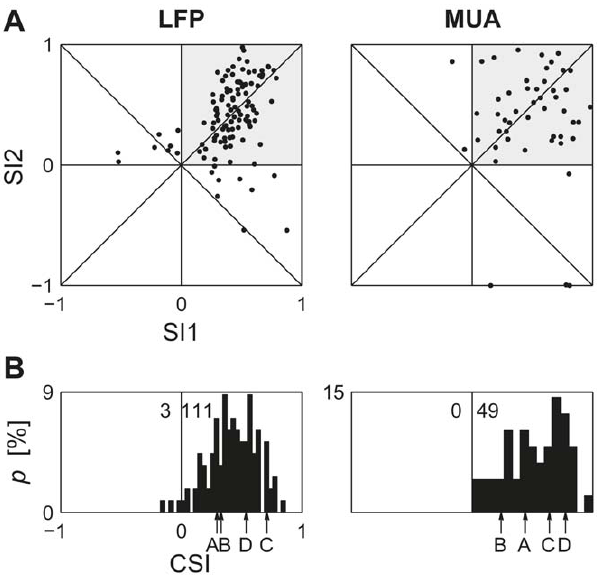
Figure 2. SSA indices for D f=44%. A. Scatter plots of SI2 vs. SI1 for all sets with D f=44%. B. Histograms of CSI. The numbers near the zero line indicate the number of CSIs smaller and greater than 0. The labels A – D mark the bins corresponding to the data in Figure 4.